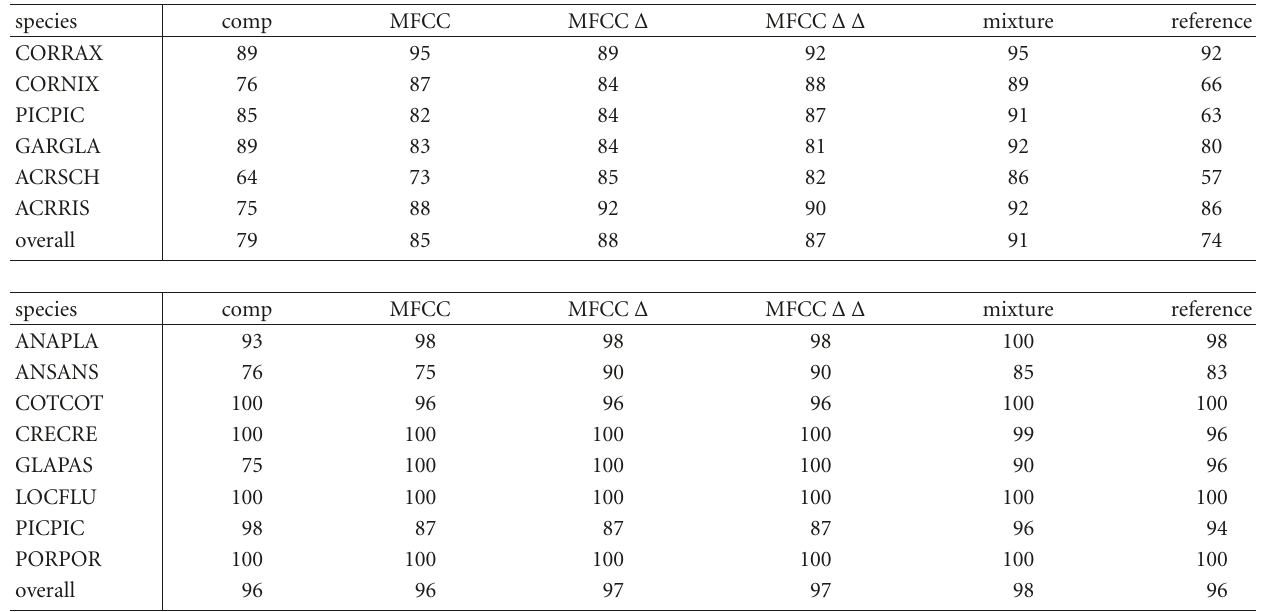
Table 4: Recognition results for datasets 1 and 2 (upper and lower panel, resp.). Values indicate the percentage of correctly classified syllables for each species using di ff erent parametric